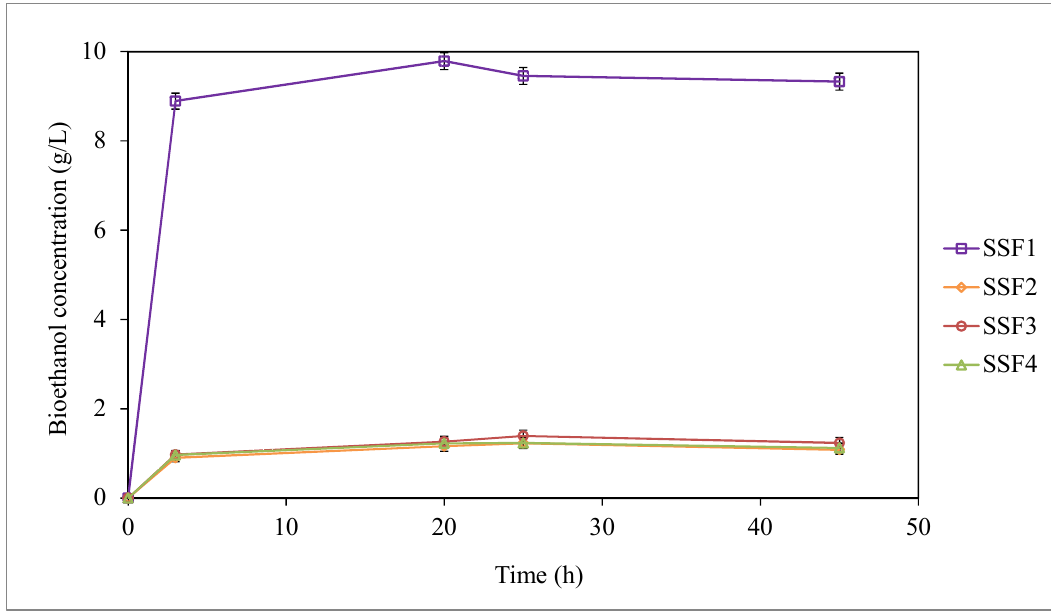
Table 3. Experimental results obtained in the SSF of untreated SSS and pretreated solid phases from selected pretreatments.